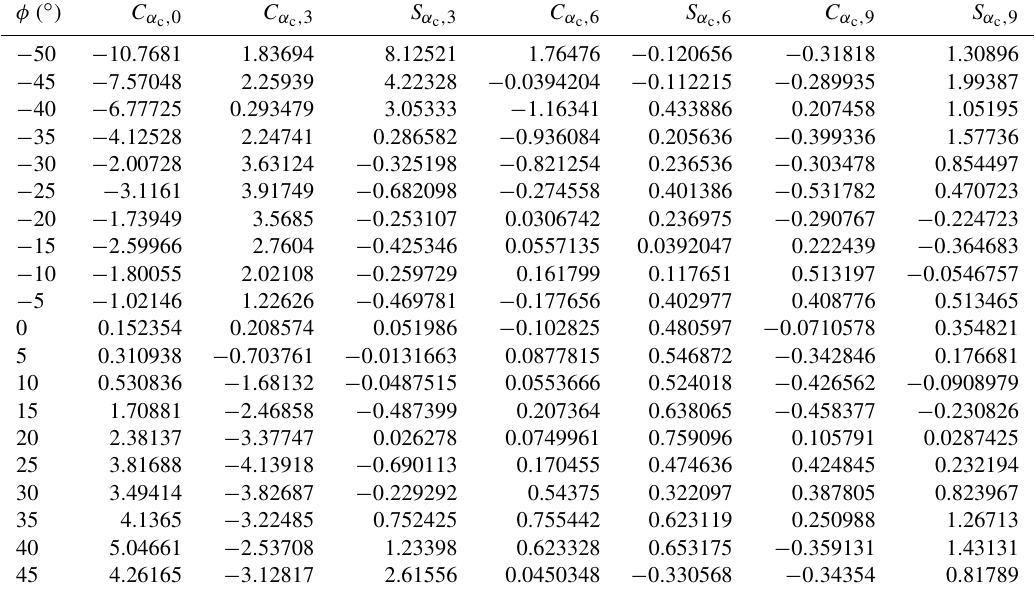
Table A1. LUT for α c (α,φ) .